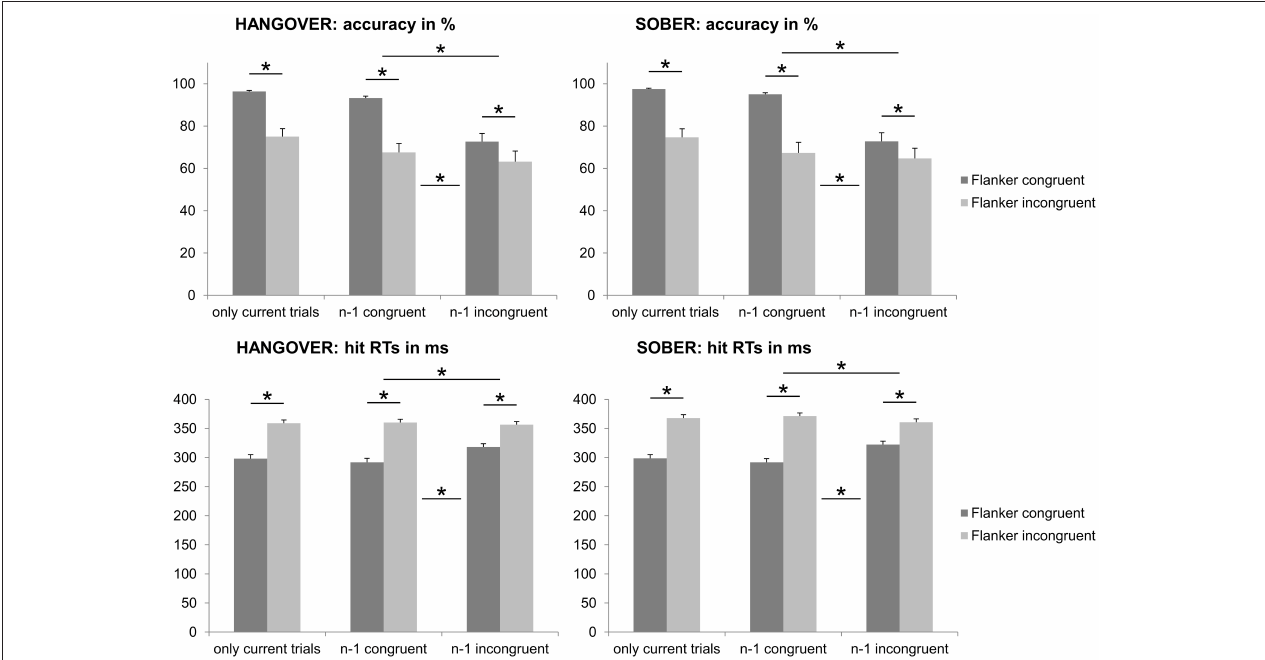
FIGURE 4 | Illustration of the behavioral results obtained with the Eriksen Flanker task. We observed a flanker effect in both behavioral measures, which was reflected by significantly decreased accuracy and increased RTs in case of incompatible flankers, as compared to compatible flankers (see left column of all graphs). We furthermore found the Gratton effect (i.e., larger flanker effects when the n − 1 trial was congruent, as compared to incongruent) in both behavioral measures (see middle and right column of the graphs). The hangover status did however not modulate any of those measures. Please note that in the upper graphs, the percentages in the left column of each graph are higher as all trials with a correct response were included, whereas both the current and previous (i.e., n − 1) trial had to have a correct response to be included in the analyses depicted in the middle and right columns of the upper graphs. Error bars denote the standard error of the mean (SEM). Asterisks denote significant